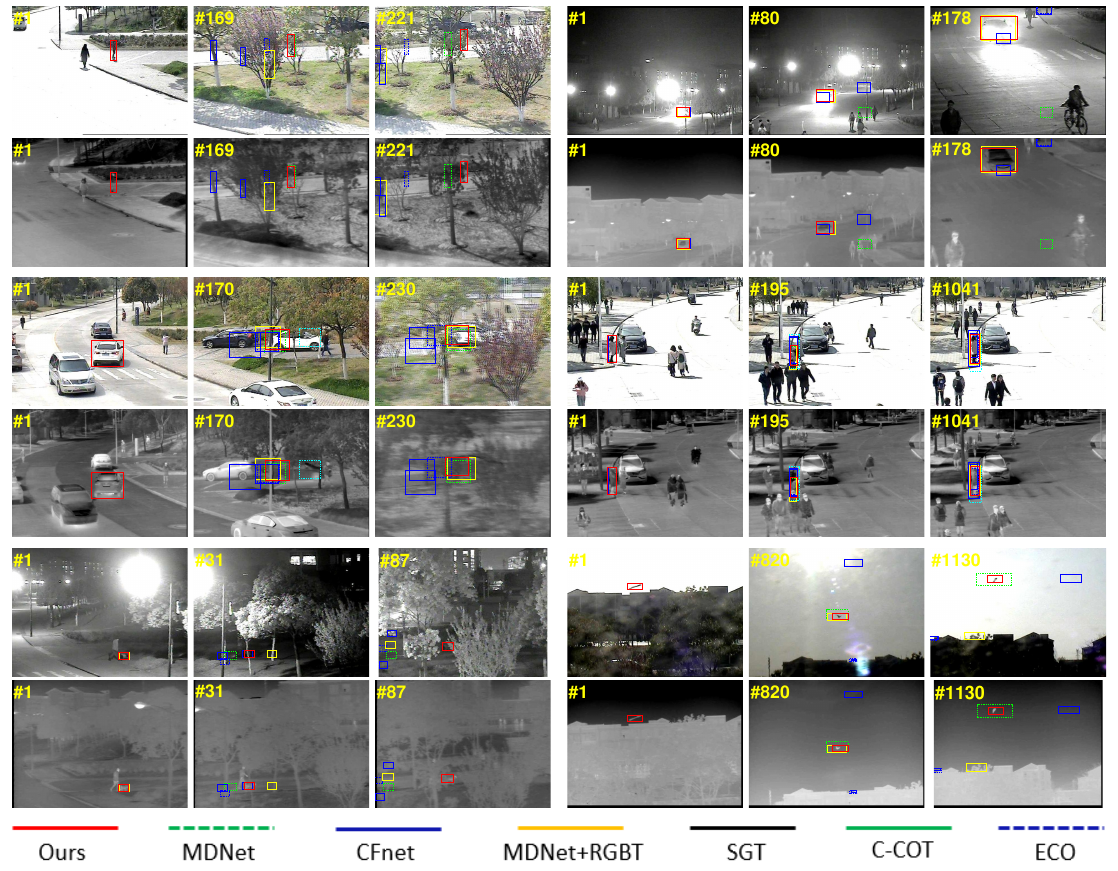
Figure 8. Qualitative comparison of our MaCNet versus three state-of-the-art RGB trackers and three state-of-the-art RGB-T trackers on six video